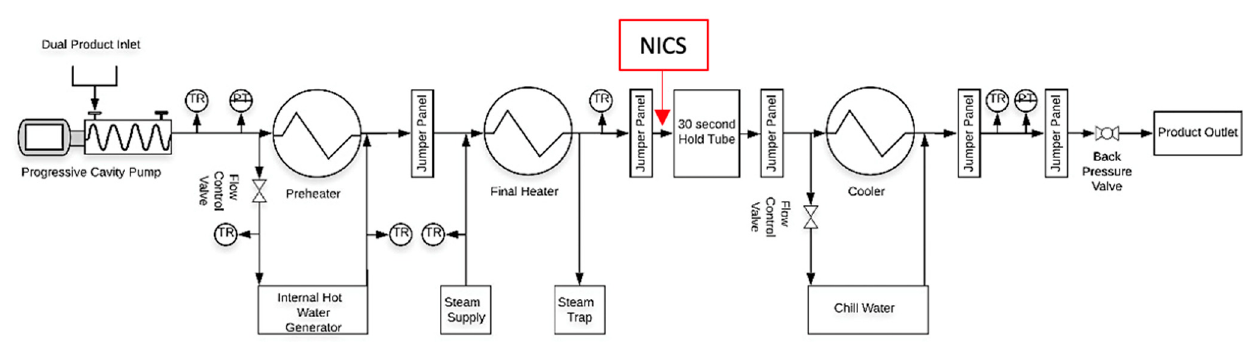
Figure 1. Process flow diagram of the Ultra-High Temperature (UHT) system used for fouling thickness determination.